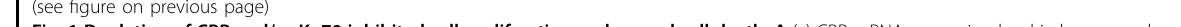
respectively ( P < 0.05, Fig. 1Aa, Ac). The effects of co- transfections on cell proliferation are presented in Fig. 1Ae. As it can be seen in Fig. 1Ae, the proliferation of A375 cells were found to be signi fi cantly inhibited in the